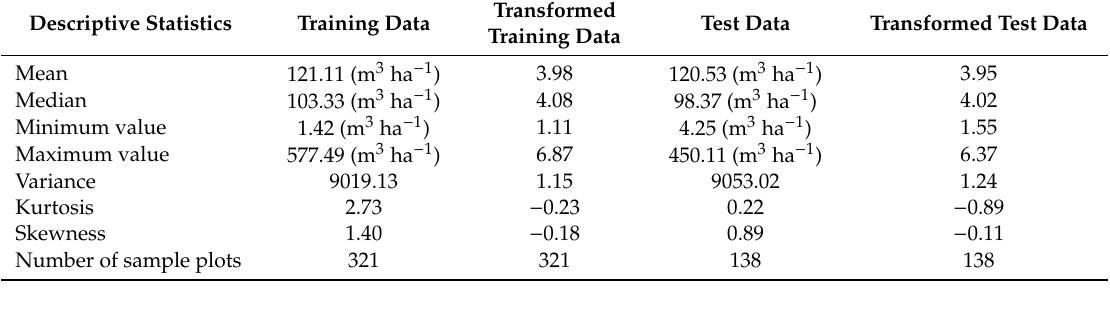
Table 4. Summary statistics for the FSVs of the training data and test data.